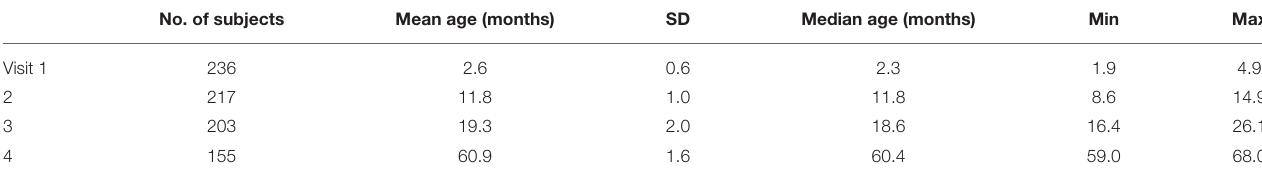
TABLE 1 | Age distribution of the study population.